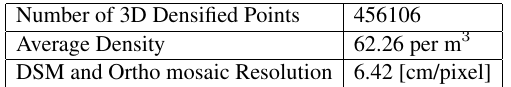
Figure 7. Image of the recorded sequence. One can see the so- lar panels on the roof including the shadow of the trees and the distortion of the image.